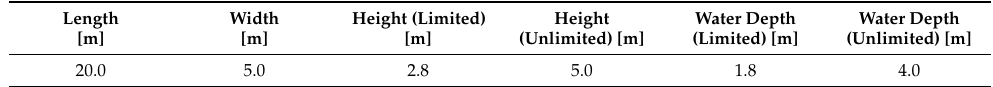
Table 4. Dimensions of the hexahedral computational domain.